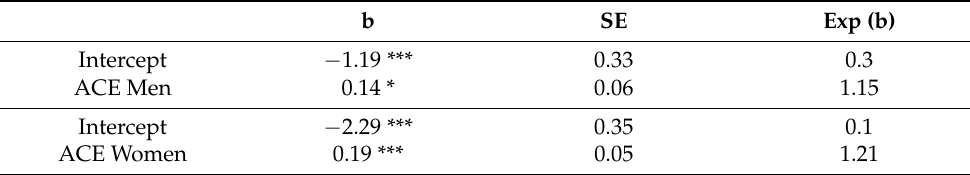
Table 12. Poisson model for alcohol and/or substance use problems by sex. b SE Exp (b) Intercept − 1.19 *** 0.33 0.3 ACE Men 0.14 * 0.06 1.15 Intercept − 2.29 *** 0.35 0.1 ACE Women 0.19 *** 0.05 1.21 Note : p > 0.0001 *** p < 0.01 *.